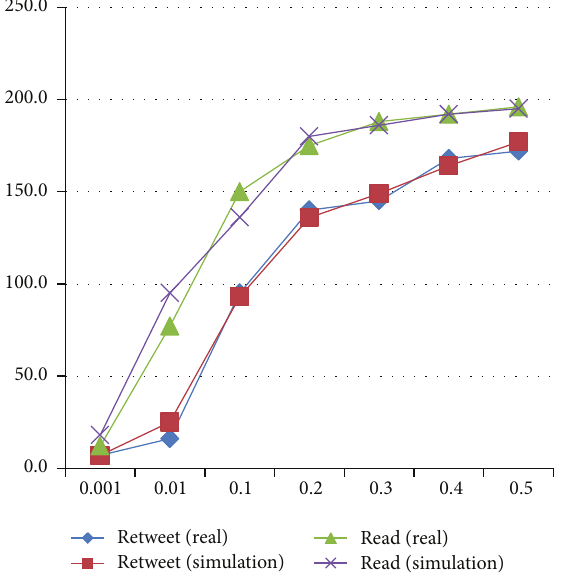
Figure 5: The relationship between the similarity of users’ interests with the content and knowledge propagation.